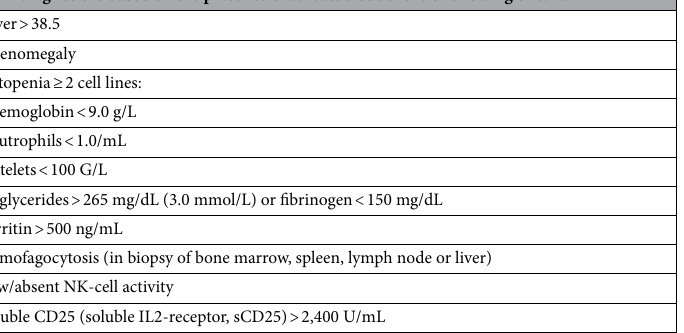
Table 1. HLH syndrome criteria according to the HLH-2004 diagnostic and therapeutic guidelines. Adapted from 10